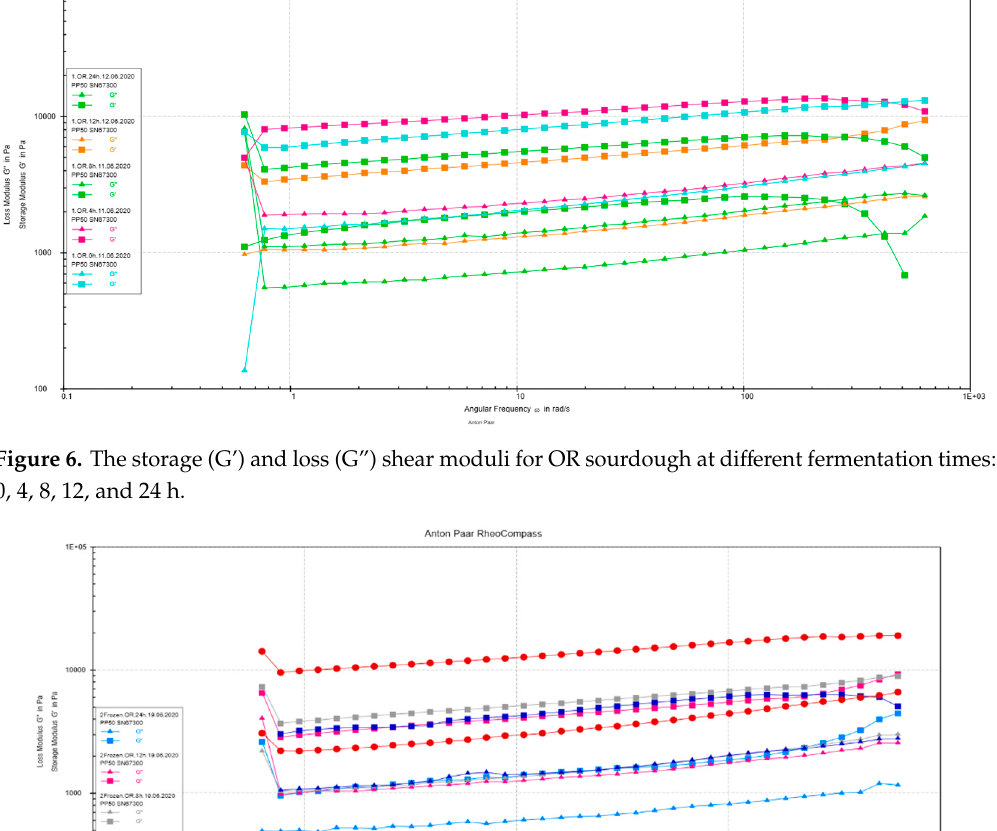
Figure 5. The storage (G’) and loss (G”) shear moduli for SP forzen sourdough at different fermentation times: 0, 4, 8, 12, and 24 h.